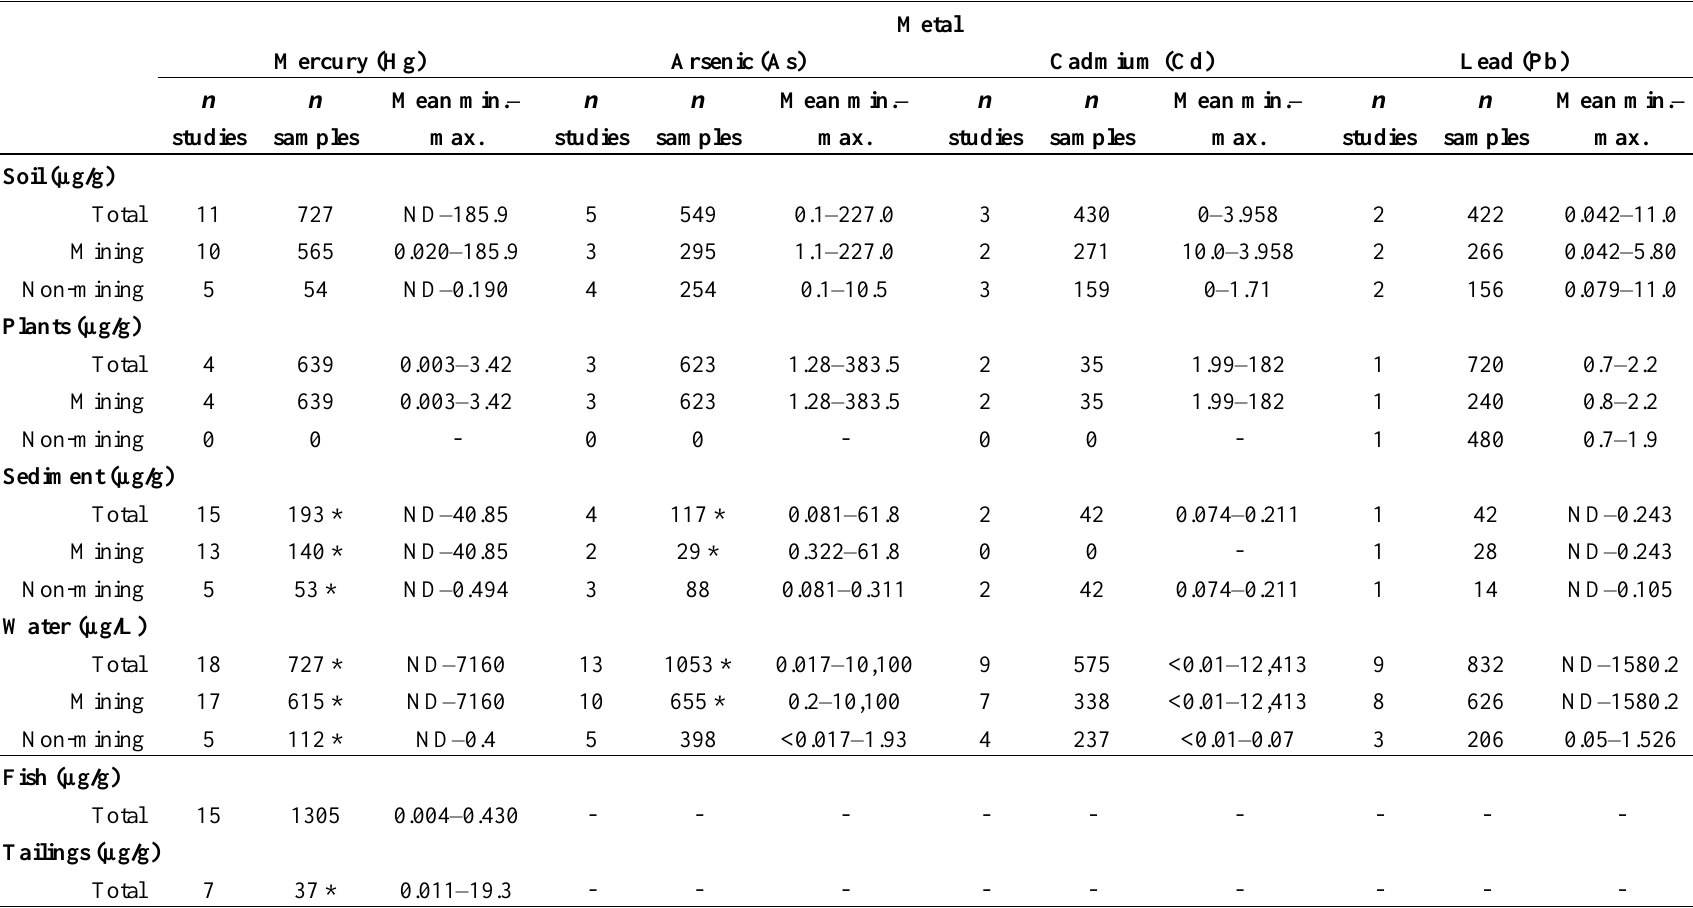
Table 2. Summaries of studies and samples reviewed for mercury (Hg), arsenic (As), cadmium (Cd), and lead (Pb), in soil, plants, sediment, water, fish, and tailings in all studies across Ghana, and those at or near ASGM and/or LSGM (mining) or in non-mining areas. Studies without mean values reported (e.g., only minimum and maximum) are not included in the min.–max. range in this